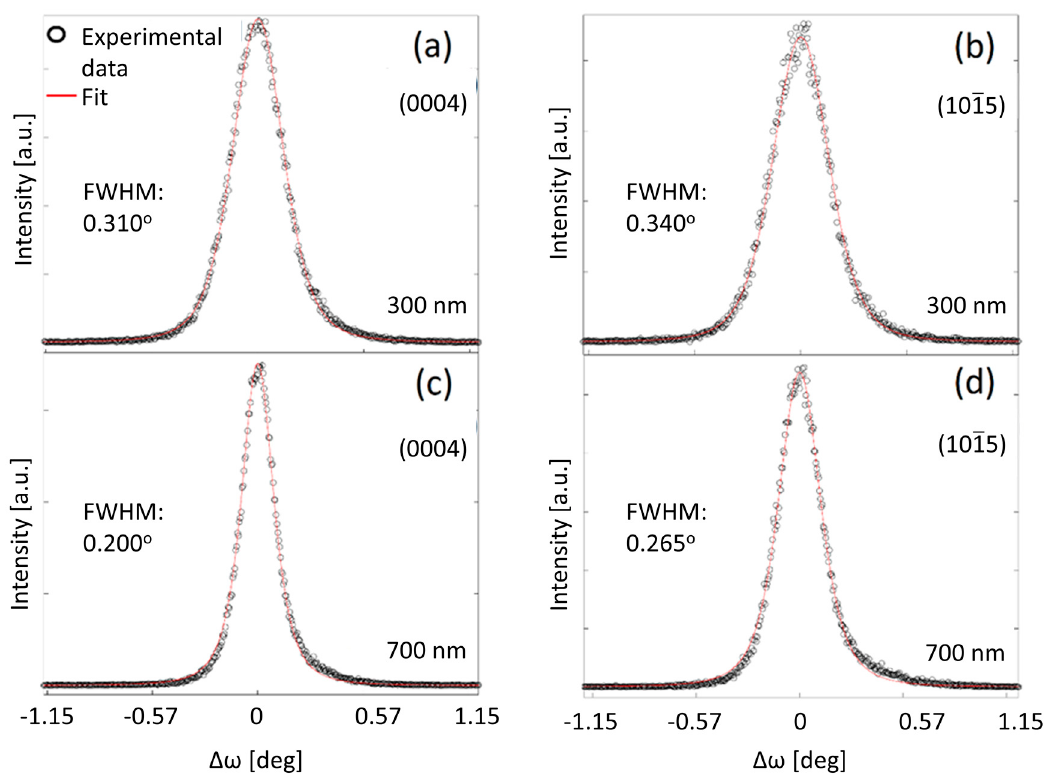
Figure 4. Experimental and simulated omega scans around ( a ) (0 0 0 4) planes of GaN in GaN300 / Si, ( b ) (1015) planes of GaN in GaN300 / Si, ( c ) (0 0 0 4) planes of GaN in GaN700 / Si, ( d ) (1015) planes of GaN in GaN700 / Si. Abbreviations: FWHM, full width at half maximum.